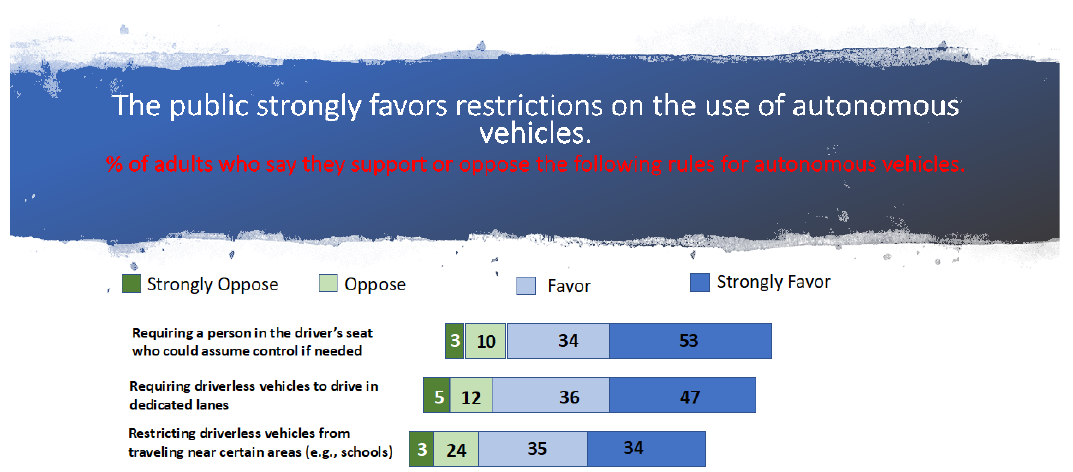
Figure 3. Public concern with autonomous vehicles remains an industry concern. Figure adapted from